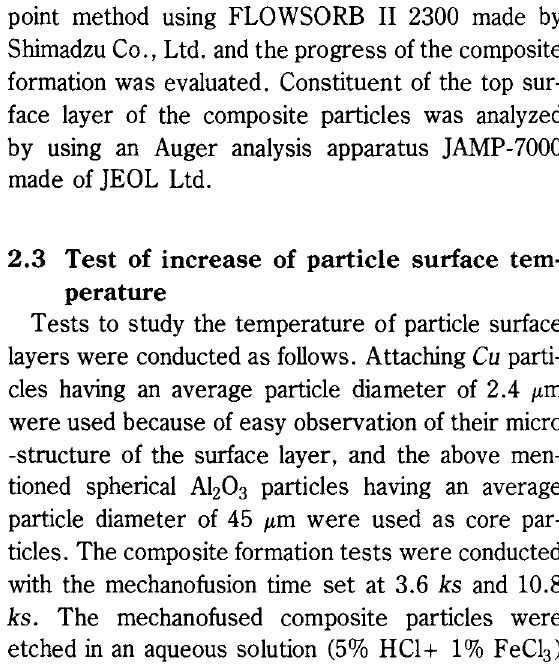
Fig. 1 Schematic outline of vacuum mechanofusion